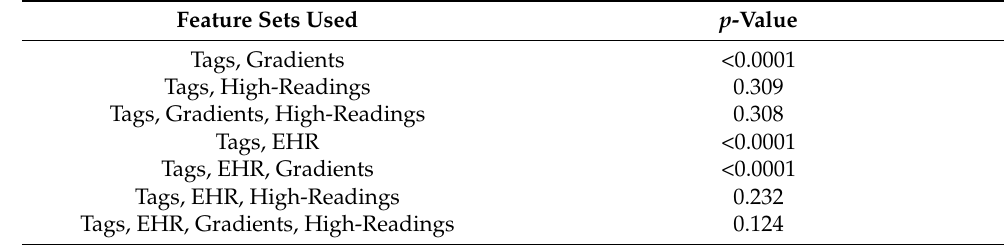
Figure A8. SHAP feature importance ranking for model trained on Tags, Gradients, High-Readings, and EHR features. Table A5. p -values (Wilcoxon Signed Rank Test) comparing outputs of each model (trained on different feature set combinations) to the baseline model (trained solely on Tags). Wilcoxon Signed Rank Test implemented using the statistics package from the SciPy library (scipy.stats).